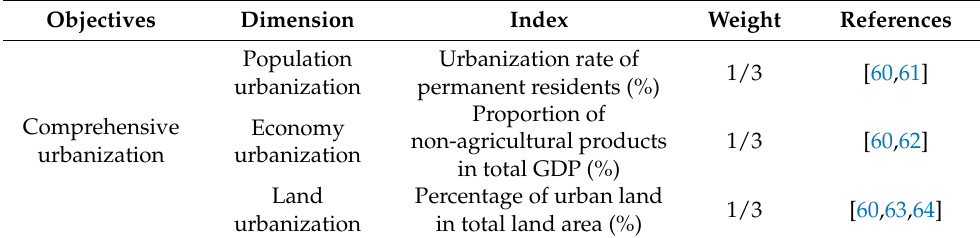
Table 3. Evaluation system for comprehensive urbanization